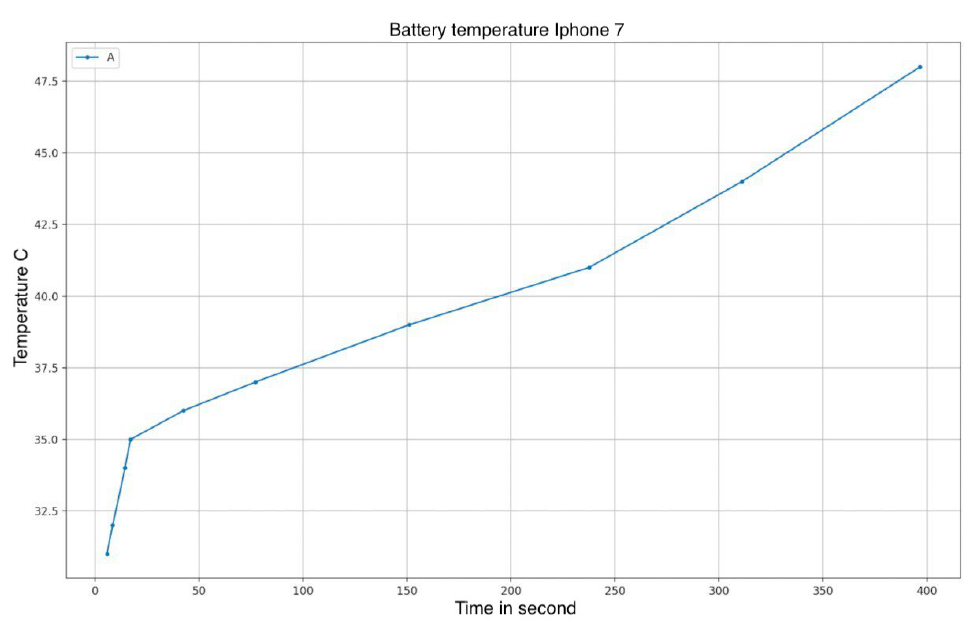
Figure 11. Battery level during the ramp test.